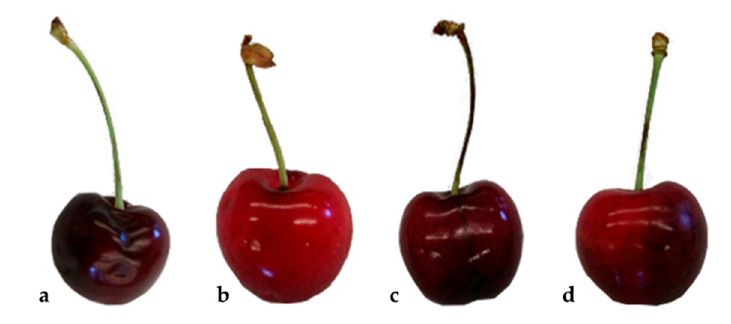
Figure 1. Sweet cherries: ( a ) Durona, ( b ) Lapins, ( c ) Summit, and ( d ) Van cultivars.